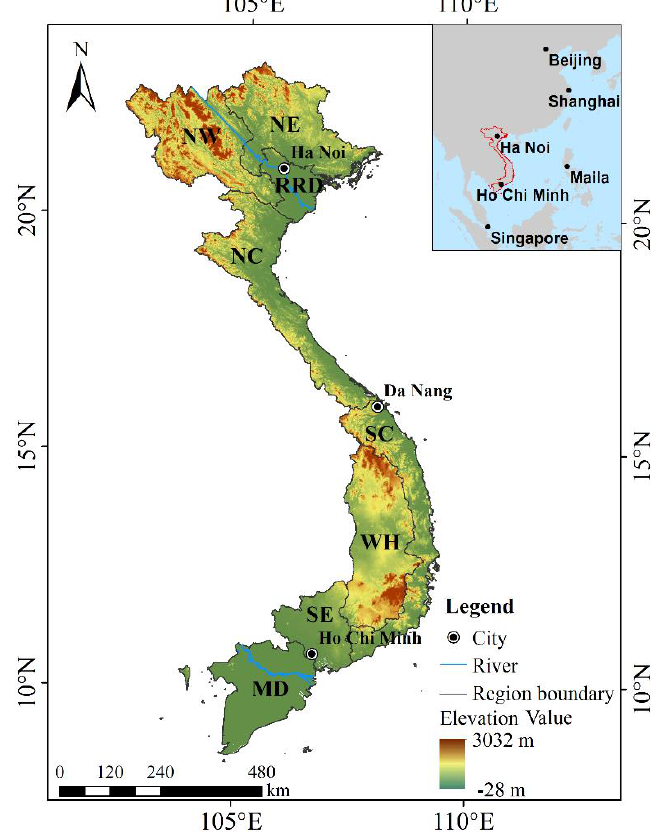
Figure 1. Location and topography map of Vietnam. NW: Northwest, NE: Northeast, RRD: Red River Delta, NC: North Central Coast, SC: South Central Coast, WH: West Highland, SE: Southeast, MD: Mekong River Delta.